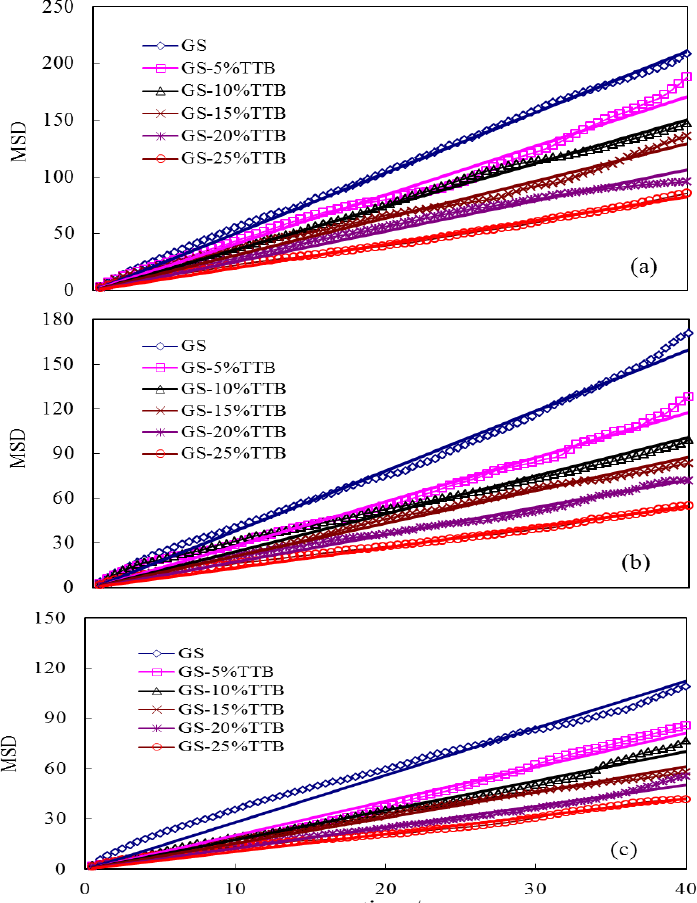
O; ( b ) NO and ( c ) SO as a 2 2 2 ), 0%–25%